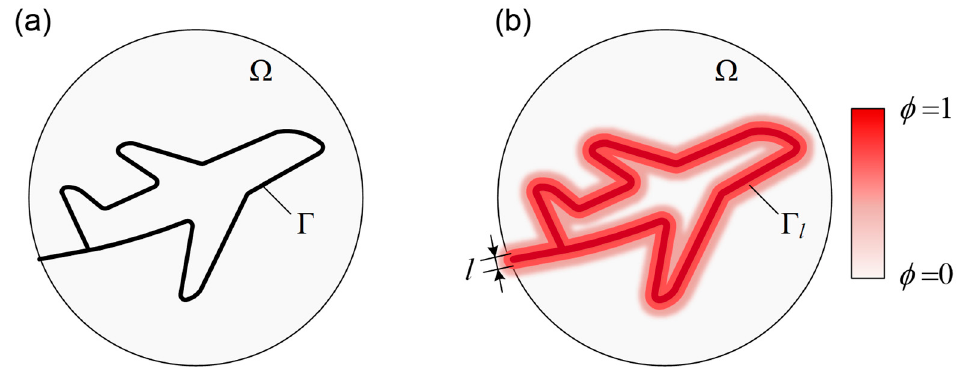
is the crack surface density function. Figure 2. Sharp ( a ) and di ff usive ( b ) crack topologies.